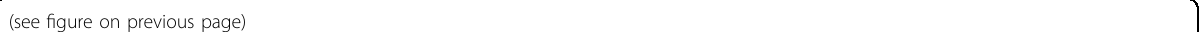
Fig. 6 MRE11 is cleaved in cells and in vitro by the SPRTN metalloprotease and SPRTN overexpression increases radiosensitivity. A siRNA- targeting SPRTN in RT112 cells regulates the levels of TR-MRE11. siRNA was used indicated concentrations 40, 60, 80 and 100 nM for 72 h, with scrambled siRNA as a positive control. Pictures are representative from 3 replicates with similar results. B Quanti fi cation of TR-MRE11 and SPRTN knockdown level from ( A ). C A signi fi cant correlation was found between TR-MRE11 and SPRTN protein expression levels ( p = 0.011). D Clonogenic survival rates of SPRTN overexpressed cells were lower after IR than for WT cells in RT112. The response to ionising irradiation is represented by the linear-quadratic model. MRE11 KD + SPRTN cells had signi fi cantly lower survival rate than WT + SPRTN cells ( P < 0.05). WT + SPRTN cells had signi fi cantly lower survival rate than WT ( P < 0.05). E SPRTN overexpression in WT and MRE11 KD cells was con fi rmed by Western blotting. F The representative images of ( D ). G In vitro cleavage assay using recombinant proteins. TR-MRE11, indicated with arrow, was released only in the presence of active SPRTN. A blot for anti-MRE11 (C-terminus) antibody shows nonspeci fi c binding to SPRTN protein, marked with asterisk. Cdc25A was used as a positive control for SPRTN activity (the size of the cleaved products is ~5 kDa smaller than the products in Fig. 2D, as this recombinant protein does not include tag part in C-terminus). H Immunoprecipitation of 293T cell lysate using SPRTN-WT and SPRTN-E112A. p97, the strong interacting partner for SPRTN, was used as a positive control for SPRTN interacting